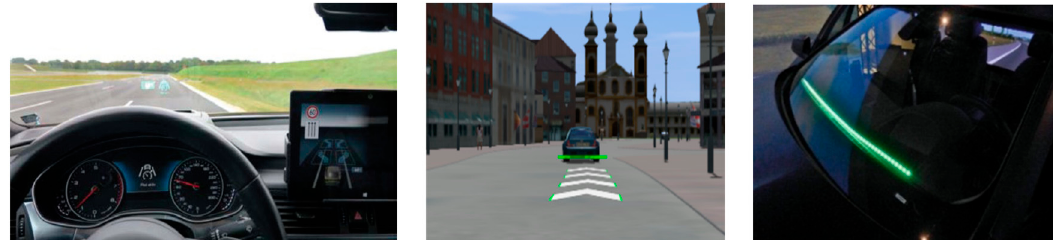
Figure 4. Most common visual HMI-elements used in aHMIs. ( a ) Instrument cluster, head-up display, and monitor in the center console used for presenting automation state and maneuvers [19]. ( b ) Augmented marking of a front vehicle and the control range in the head-up display [23]. ( c ) LED-strip in the windshield to visualize the automation mode using color-coding [21].